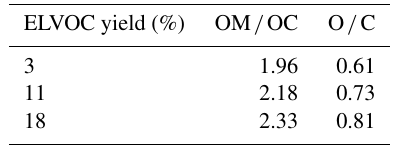
Table D2. Simulated means of the OM / OC and O / C ratios during the summer campaign of 2013 using an ELVOC molar yield of 3, 11 and 18%. The measured means of OM / OC and O / C are 2.43 and 0.99